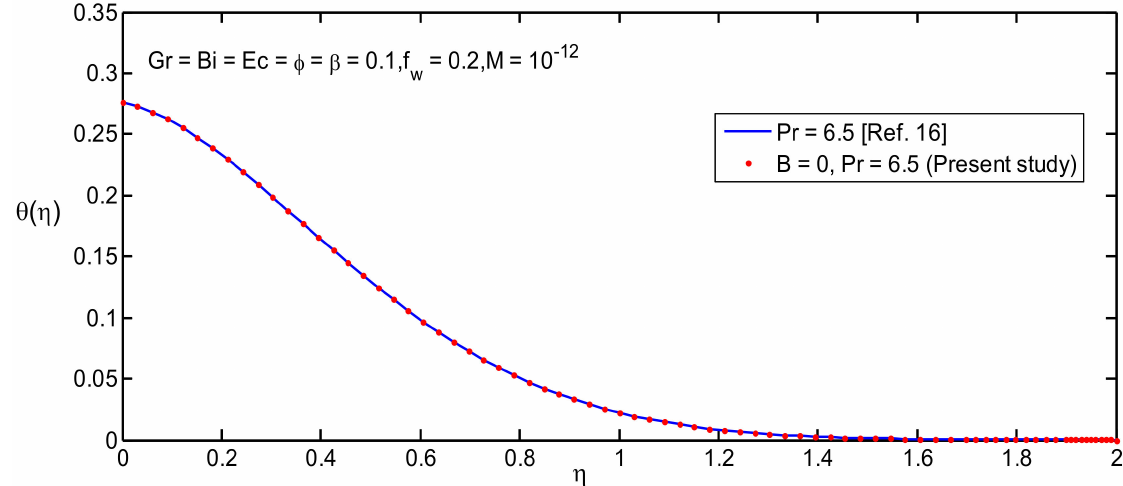
Figure 3. Comparison of Temperature profile for B = 0.